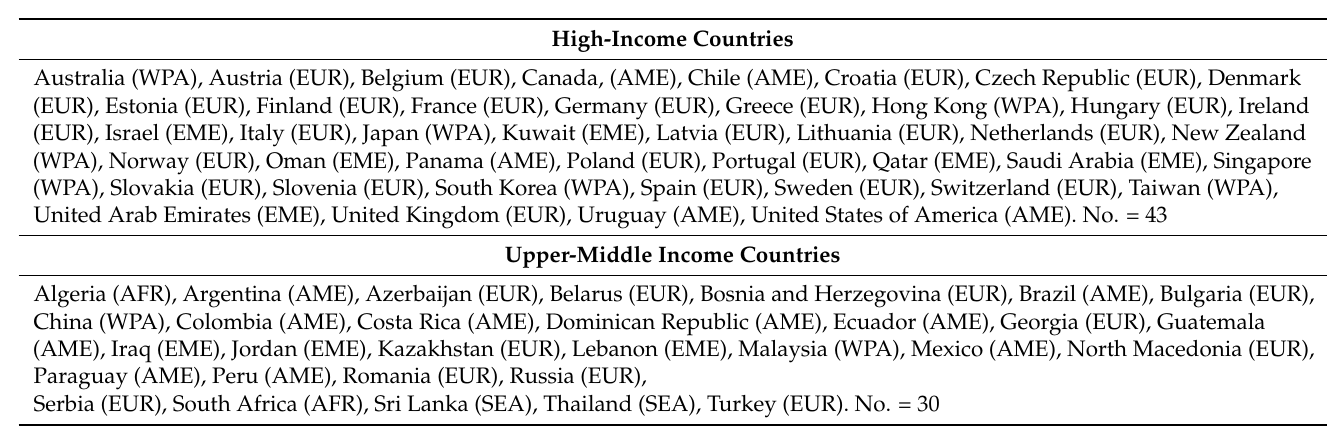
Table A1. List of countries included in the study by income